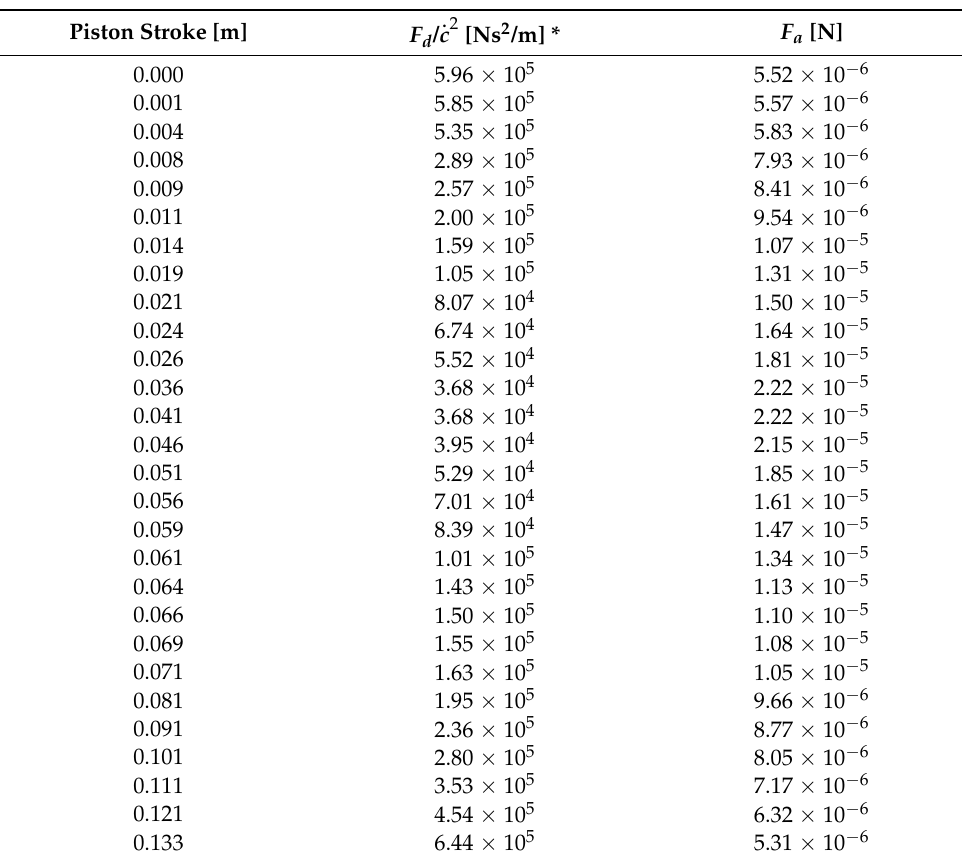
Table A4. Dissipative force coefficient and pneumatic reaction vs. piston stroke.